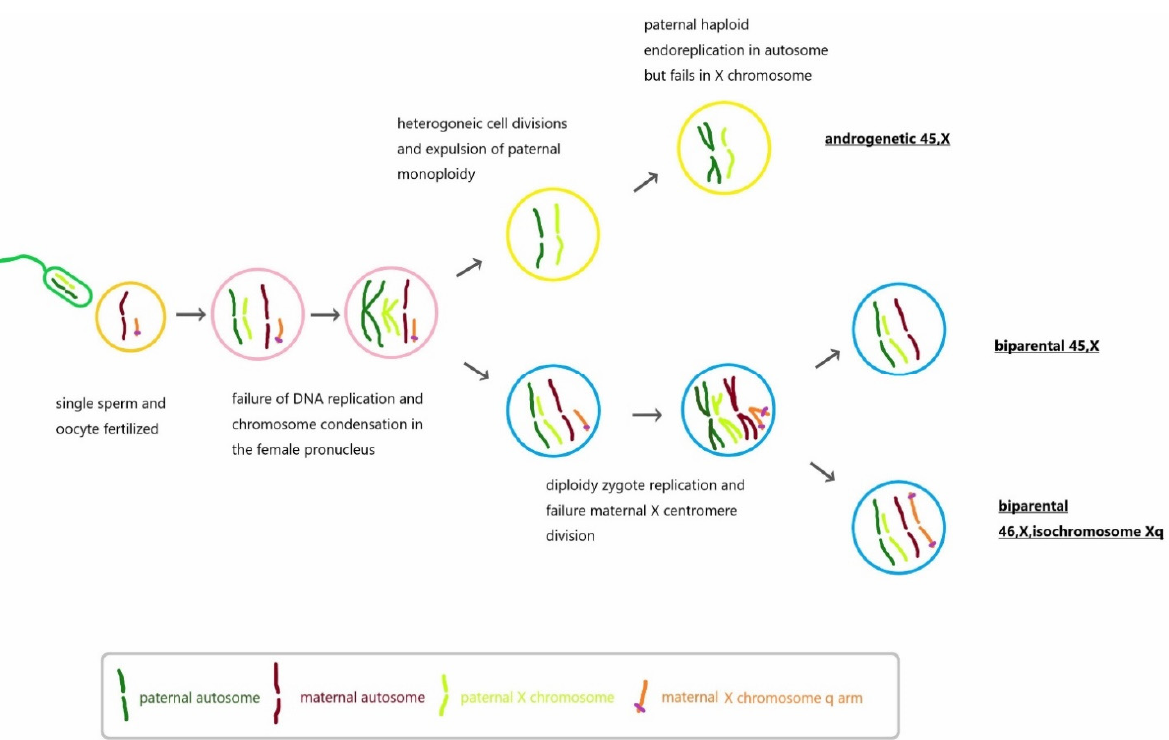
Figure 6. Hypothetical cause of biparental/androgenetic mosaicism and 46, X, isochromosome Xq/45, X mosaicism. Single sperm was fertilized with the oocyte carrying 22, Xq. Before the female pronucleus condensed, the paternal genome replicated first and was expelled as distinct cell, which is called heterogeneous cell division. The autosomes of paternal haploid endoreplicated but failed in X chromosome, resulting in the androgenetic 45, X. On the other hand, after heterogeneous cell division, the biparental zygote went through cell replication and mis-division of the centromere on X chromosome, leading to biparental 46, X, isoXq/45, X mosaicism.